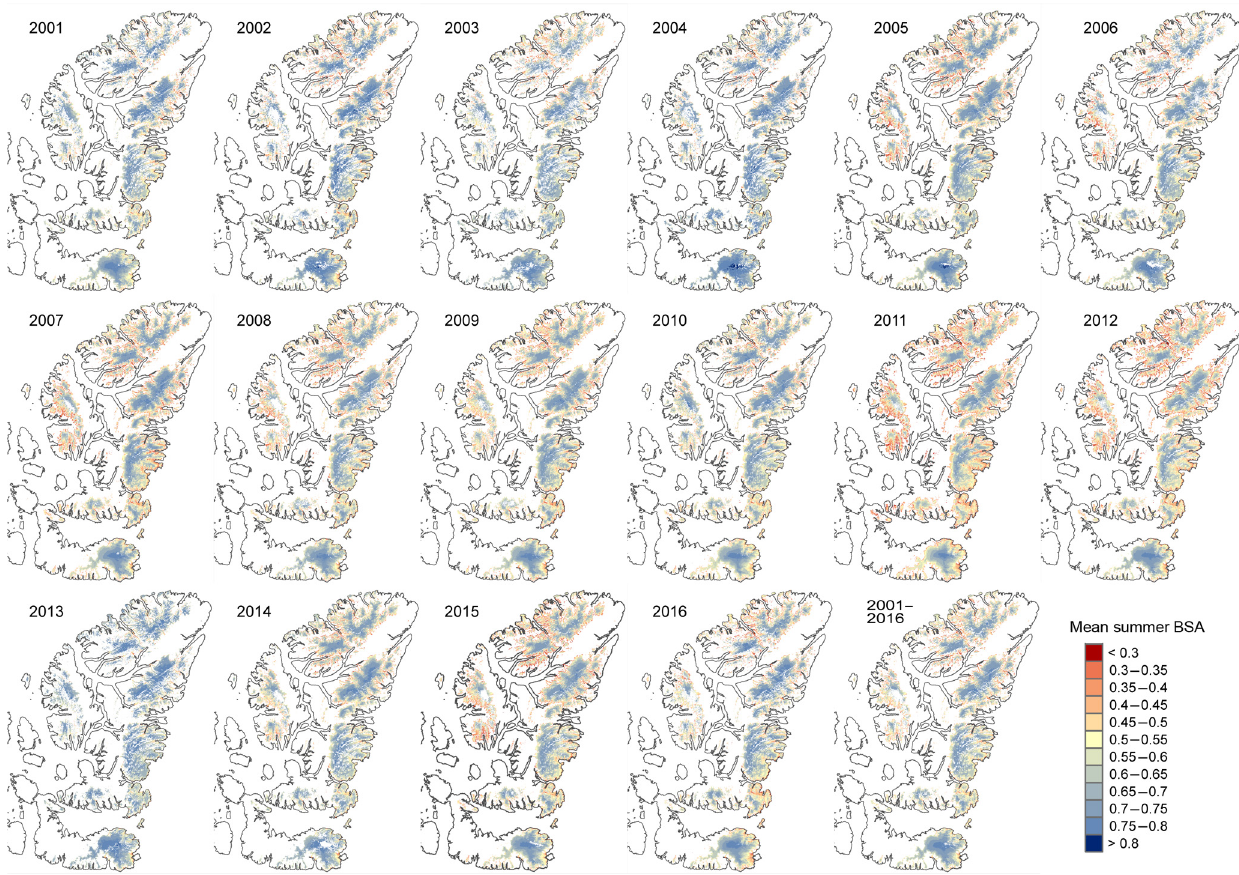
Figure 2. Mean summer clear-sky shortwave broadband black-sky albedo over the QEI ice caps. White areas outside of the ice caps indicate non-glaciated land cover. Table 1. Clear-sky BSA and LST; ± 1standard deviation. Anomalies are with respect to the 2001–2016